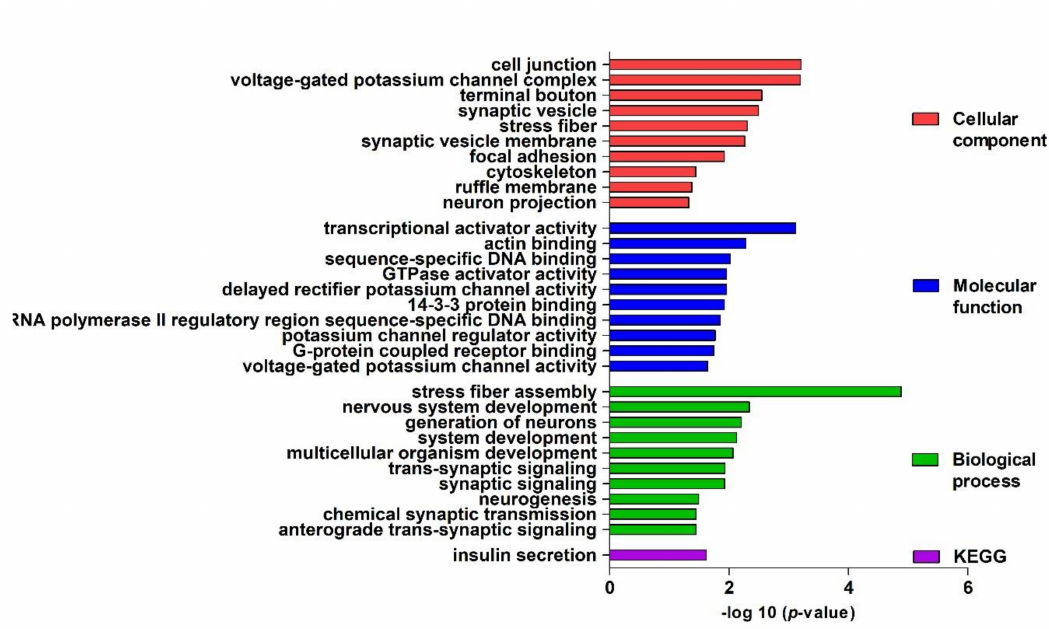
Figure 2. Gene ontology (GO) enrichment analysis. Top 10 significantly enriched GO ( − log10 ( p -value)) terms of the target genes in the cellular components, molecular function, and biological processes. KEGG, Kyoto Encyclopedia of Genes and